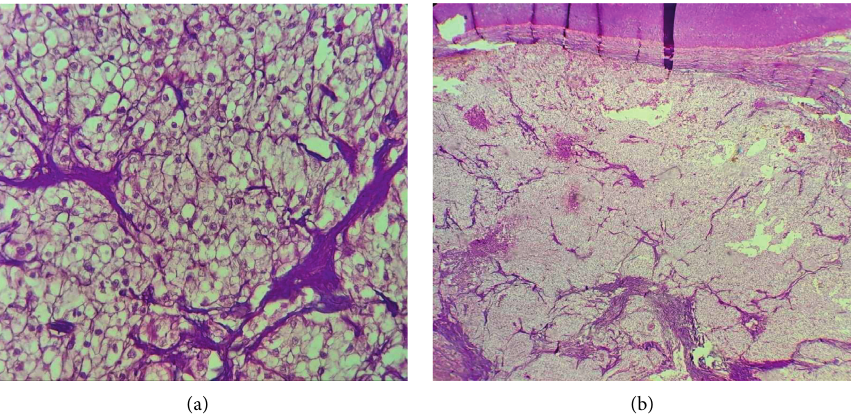
Figure 4: (a) (GX400) Clear cell carcinoma with a regular network of small and thin walled blood vessels. (b) (Gx200) Clear cell carcinoma with solid alveolar arrangement of